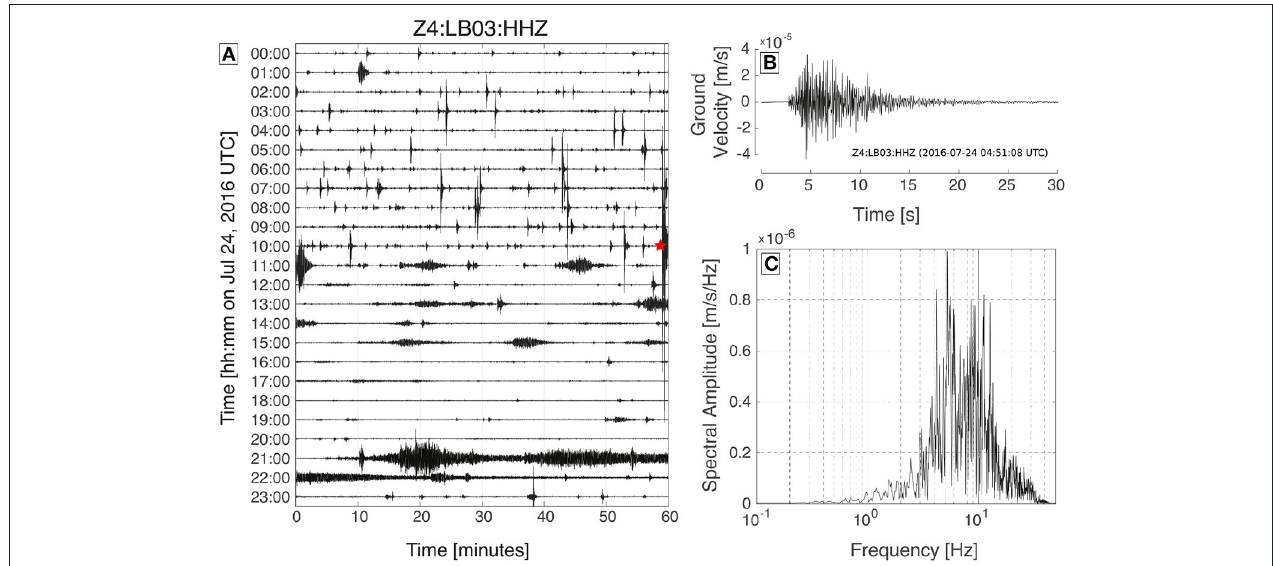
FIGURE 10 | (A) 24-h helicorder from station LB03 on 24th July 2016 showing a short swarm of volcano-tectonic earthquakes from 00:00 to 11:00 UTC, followed closely by an explosive event (red star). The explosion is followed by a sequence of rockfall events, as well as two seismo-tectonic events. The long-lived high amplitude event from 21:00 to 22:30 is likely an unreported lahar. (B) The waveform and (C) frequency spectrum of one volcano-tectonic earthquake during the swarm in (A) , demonstrating the high-frequency nature of the volcano-tectonic